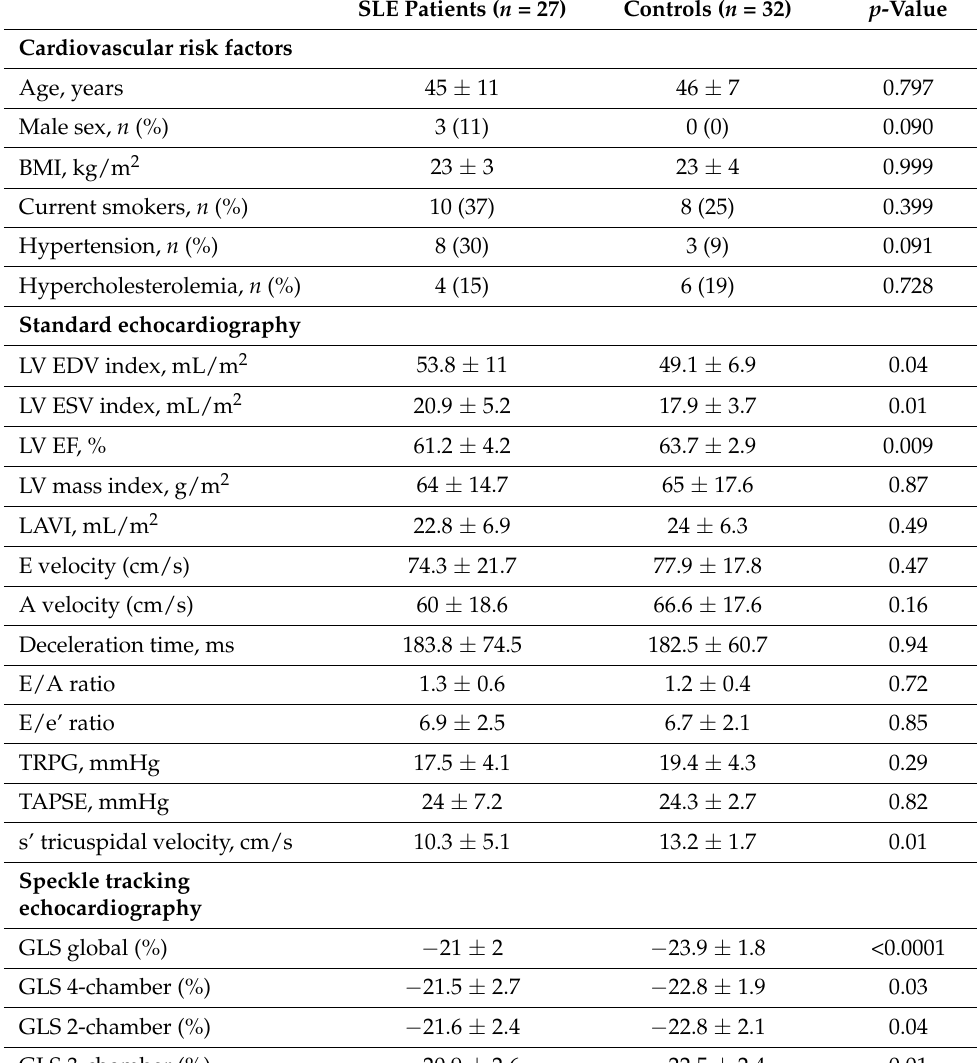
Table 1. Cardiovascular risk profile and echocardiographic features in SLE patients and control